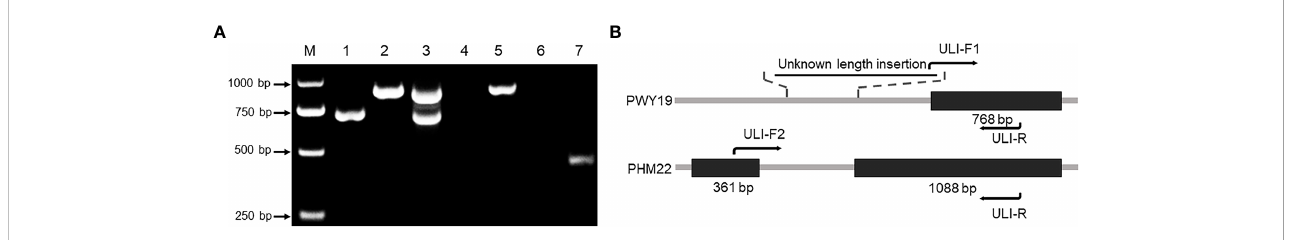
FIGURE 5 Variation of PsXI gene between PWY19 (bruchid-resistant) and PHM22 (bruchid-susceptible). (A) PWY19 (lane 1), PHM22 (lane 2), and their F 1 hybrid (lane 3) were ampli fi ed using sequence-speci fi c primers ULI-F1/ULI-F2/ULI-R. Lanes 4 and 5 represent ampli fi cation from genomic DNA of PWY19 and PHM22 using ULI-F2/ULI-R, respectively. Lanes 6 and 7 represent ampli fi cation from cDNA of PWY19 and PHM22 using ULI-F2/ULI-R, respectively. (B) Structure of PsXI in PWY19 and PHM22. Black boxes represent coding regions.